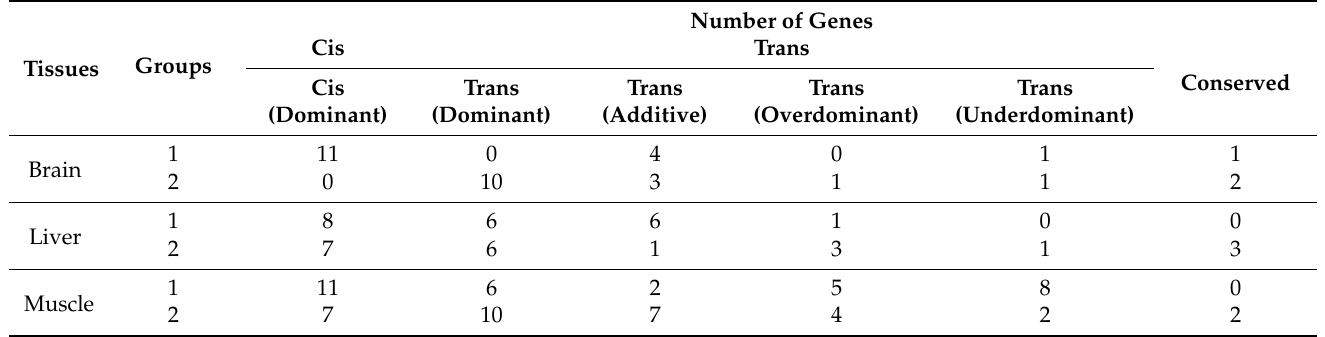
Table 1. The number of regulatory divergence categories of W-linked genes in three